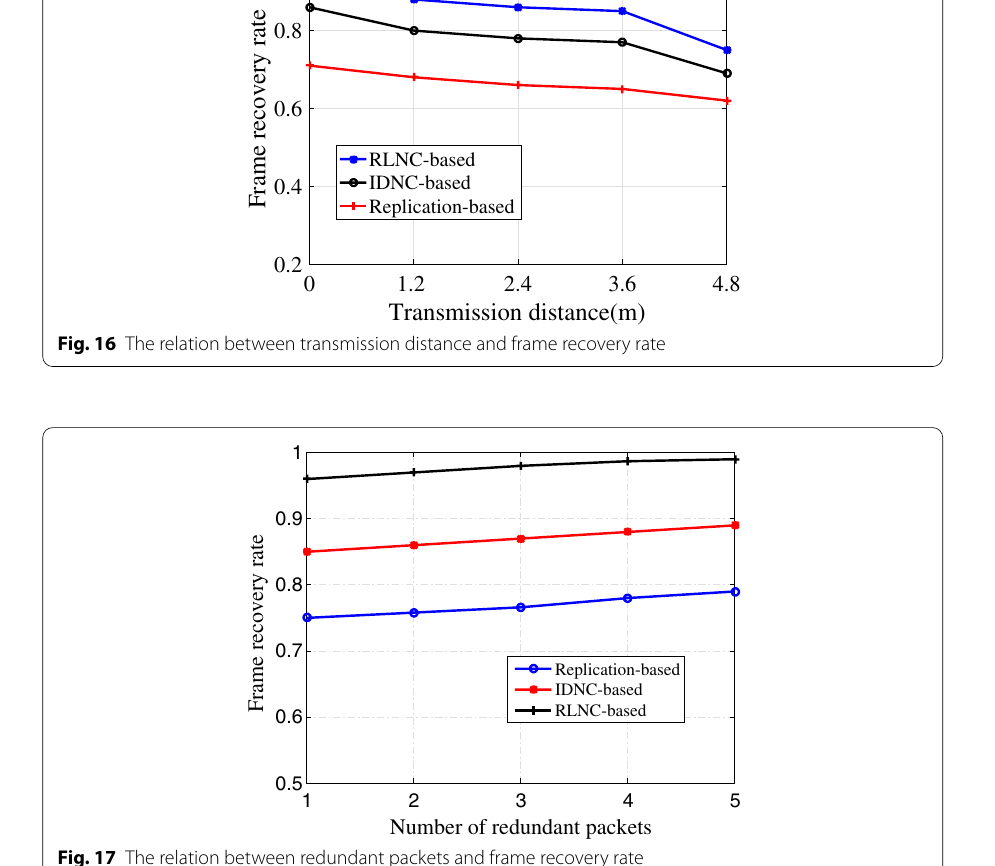
Fig. 17 The relation between redundant packets and frame recovery rate